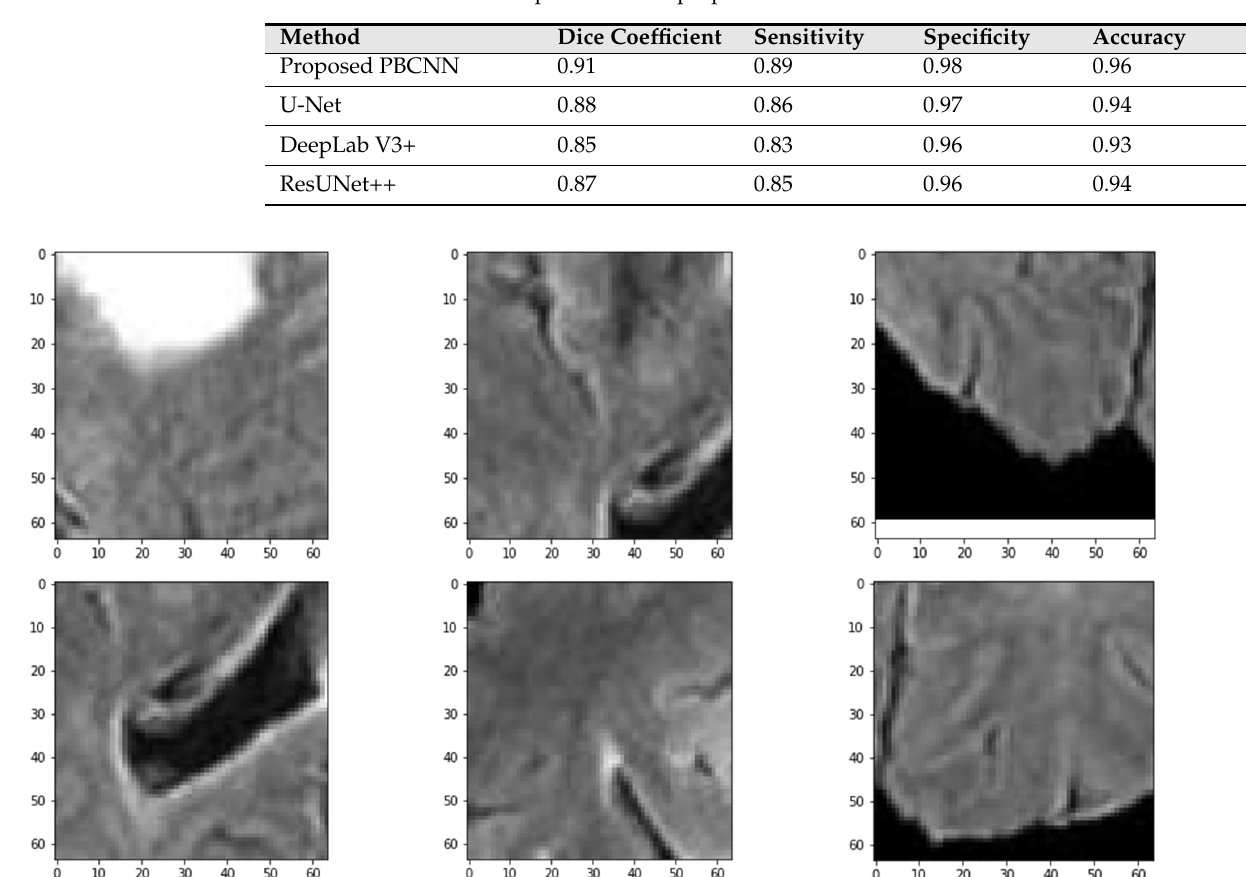
Table 15. Performance comparison of the proposed PBCNN with State-of-the-Art Methods.